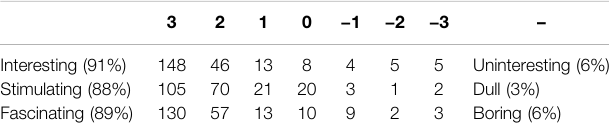
TABLE 3 | Attitudes towards working in space careers. This table shows the distribution of answers indicating the degree to which respondents felt working in a space career would be Interesting/Uninteresting (n (cid:1) 229, mean (cid:1) 2.27, mode (cid:1) 3, SD (cid:1) 1.35, variance (cid:1) 1.83), Stimulating/Dull (n (cid:1) 222, mean (cid:1) 2.09,mode (cid:1) 3,SD (cid:1) 1.16,variance (cid:1) 1.34),andFascinating/Boring (n (cid:1) 224,